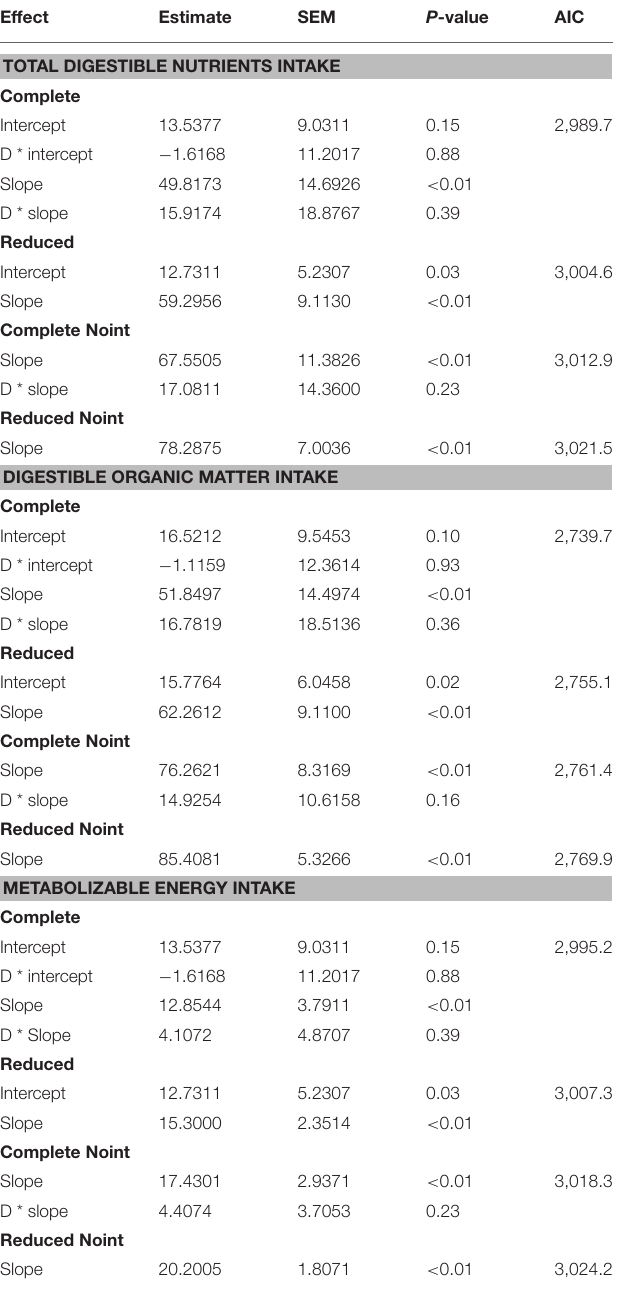
TABLE 2 | Estimated parameters and statistic evaluation of the relationships between intake of total digestible nutrients (TDN), of digestible organic matter (dOM), and of metabolizable energy (ME) intakes with ruminal microbial crude protein in complete (different parameters for each specie) and reduced (same parameters for both species) modes, where the letter “D” represents a dummy variable (D = 0 for goat and D = 1 for sheep), with models with and without intercept (Noint).